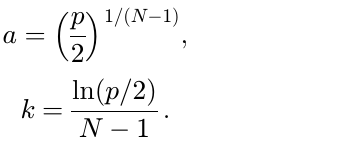
Powder injection Storage condition